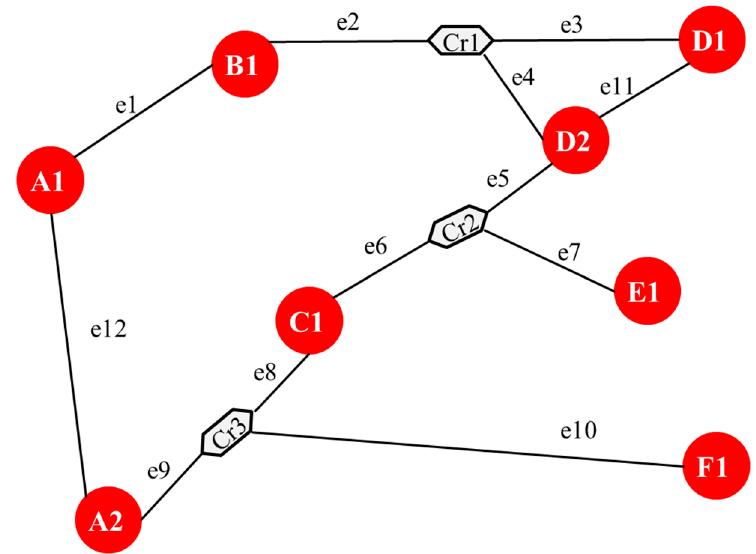
Figure 2. Graphic modeling of this chemical cluster.